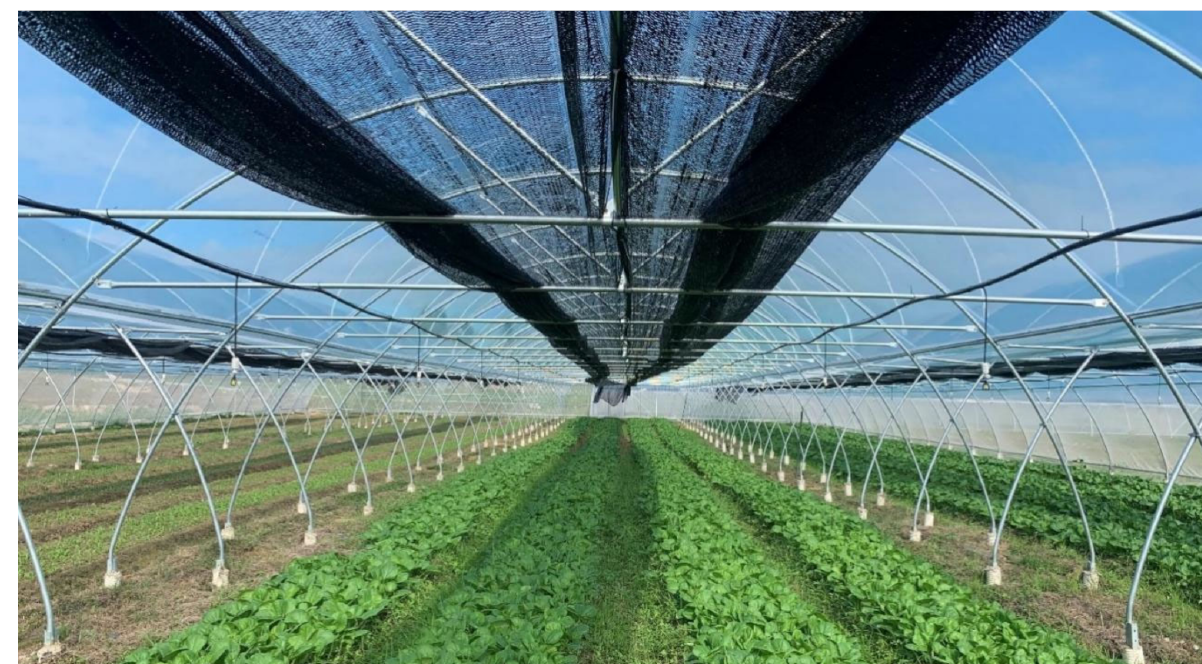
Figure 7. Production application example diagram of a multi-arch